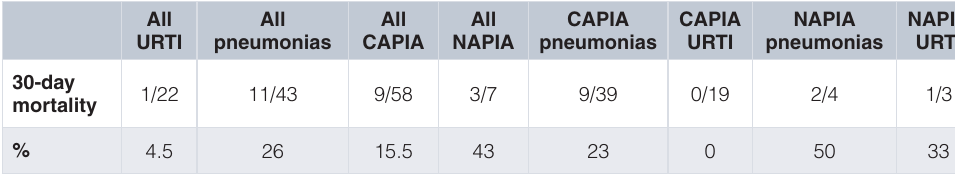
Table 2. The mortality of patients with pandemic Influenza A H1N1 infection according to the clinical presentation and